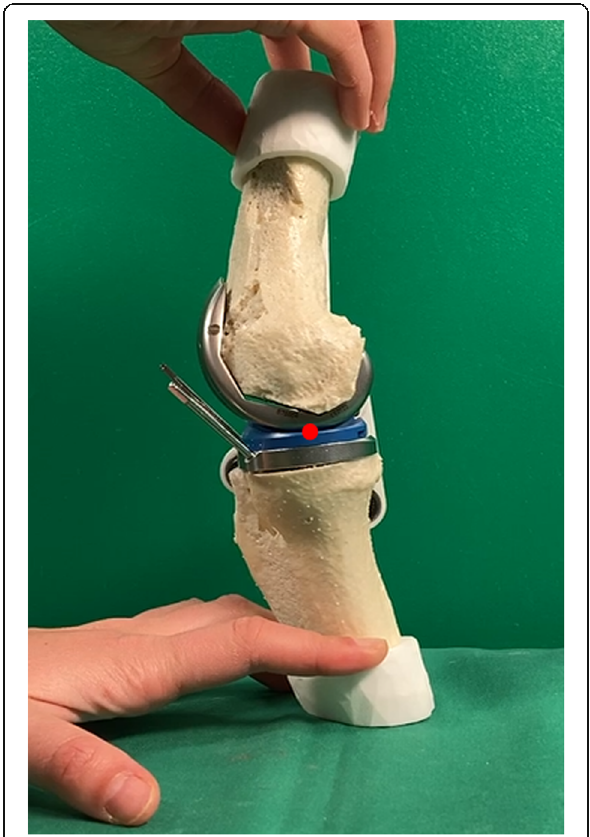
Fig. 10 Knee model after surgery, shown in the sagittal plane with the measured contact point (in red) between femur and